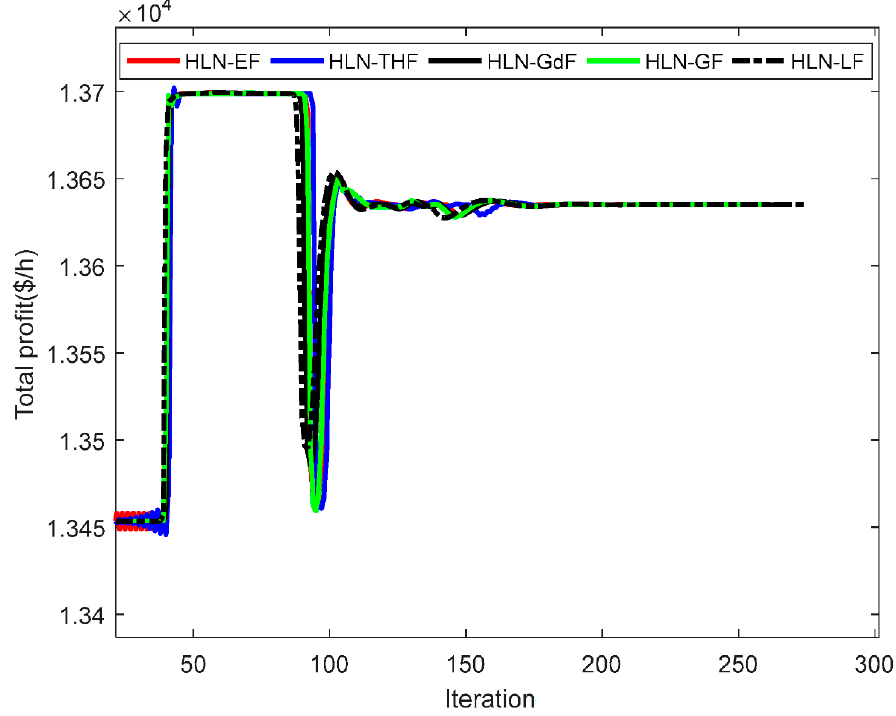
Figure 14. Total profit for the second system with the second model of payment. All of the data of the system and optimal solutions obtained by the HLN-EF for the system are shown in Tables A3 and A4 of Appendix